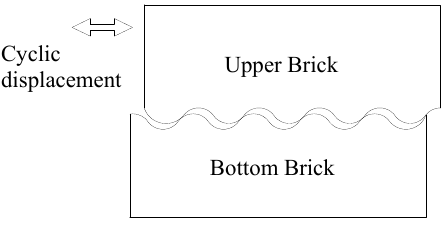
Figure 10. Sketch of the contact status for the MBs.